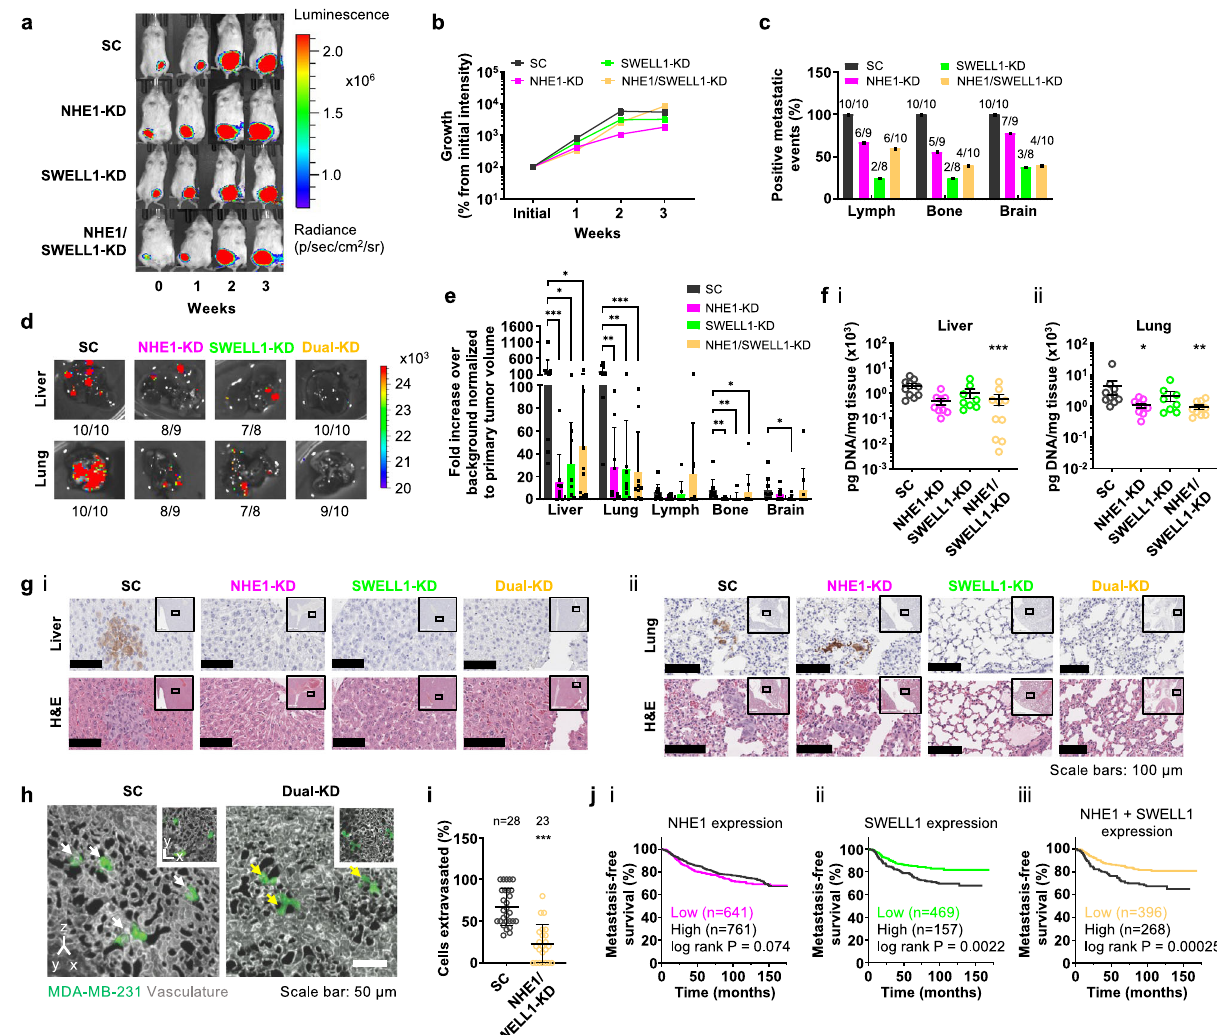
Fig. 6 | Dual NHE1 and SWELL1 knockdown blocks breast cancer cell extra- vasation and metastasis. a , b Bioluminescent images of mice following sub- cutaneous injection of SC, single NHE1-KD or SWELL1-KD, or dual-KD cells into the mammary gland. Data represent mean±SEM from 10 mice per group at the indi- cated timepoints, except for SWELL1-KD ( n =9 at week 2; n =8 at week 3). c Percentage of mice with positive metastatic events in the lymph node, bone and brainforthe indicatednumber of mice.Onemouse in a , b diedbeforeimaging for metastasis ( n =9 for NHE1-KD). d Bioluminescent images of the liver and lung of miceatendpoint. e Quanti fi cationof bioluminescentsignalfromliver,lung,lymph nodes, bone, and brain. Data represent mean±SD for the same number of mice shownin c , except for one extreme outlierinthe lymphnodesof a mouse injected with dual-KD cells. f Amount of human DNA in the (i) liver or (ii) lung of mice at endpointasdeterminedbyqPCR.Datarepresentmean±SEMforthesamenumber of mice shown in c . g Representative 10× images of adjacent (i) liver or (ii)